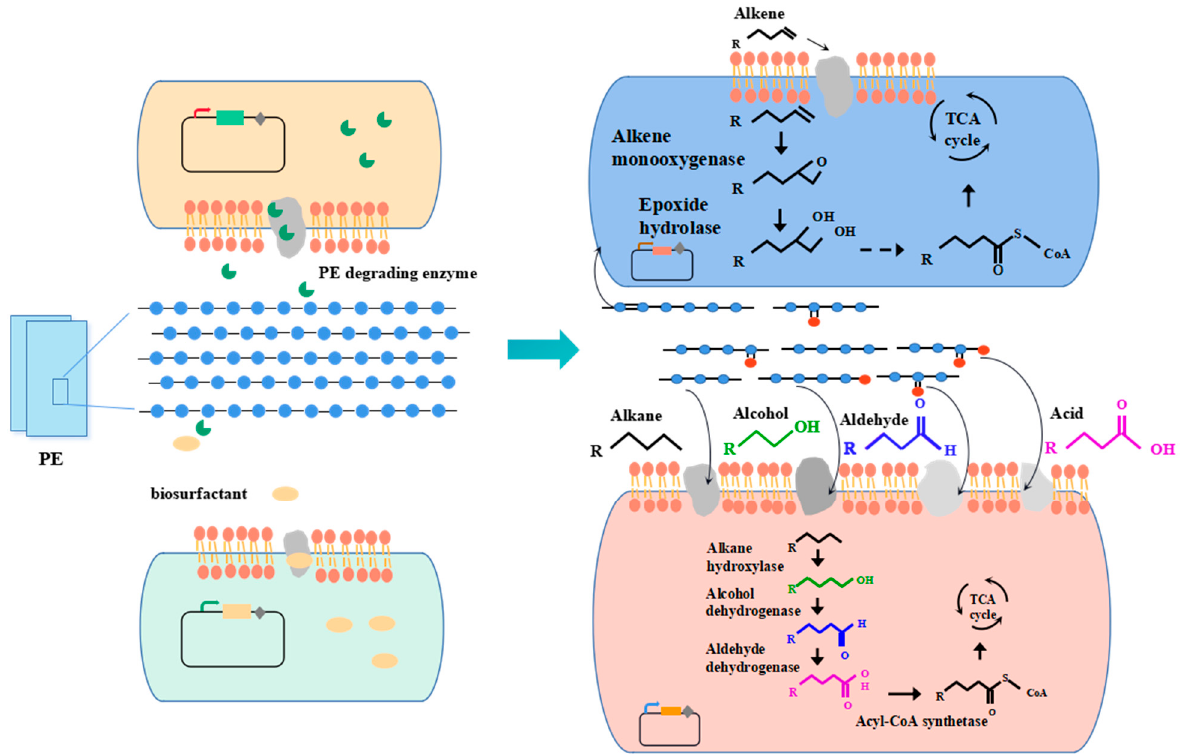
Figure 3. Artificial microbial consortia for complete PE biodegradation.